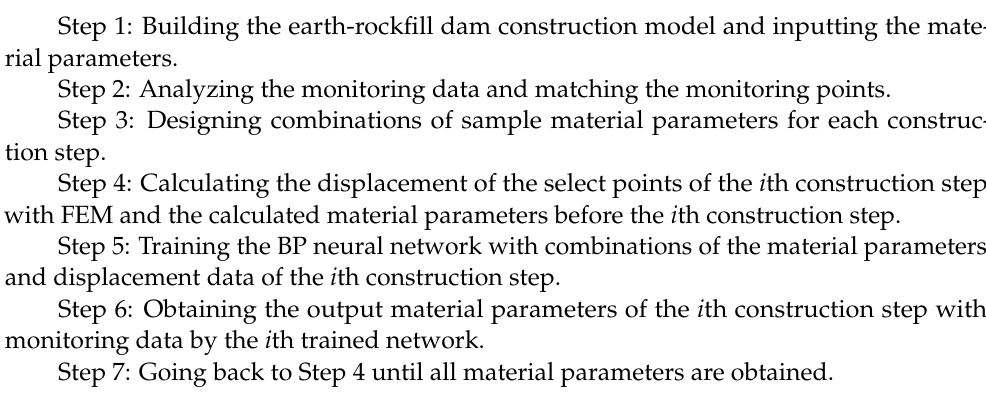
Figure 3. Outline and discrete grids of the benchmark model.